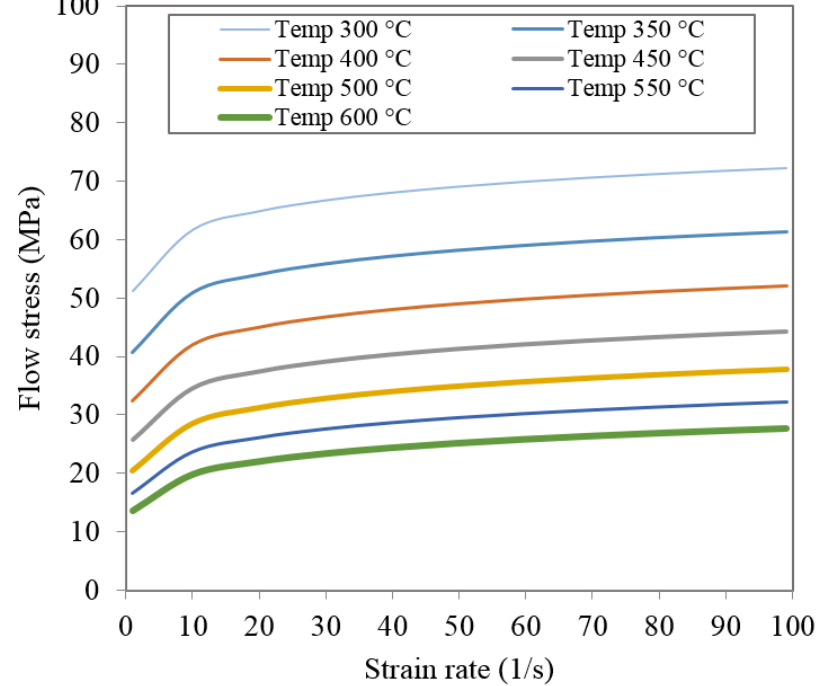
Figure 2. Flow stress of